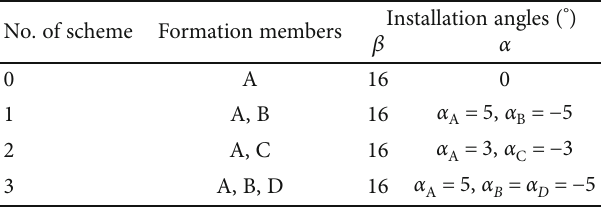
Table 8: The formation members and the installation angles for sensors of di ff erent